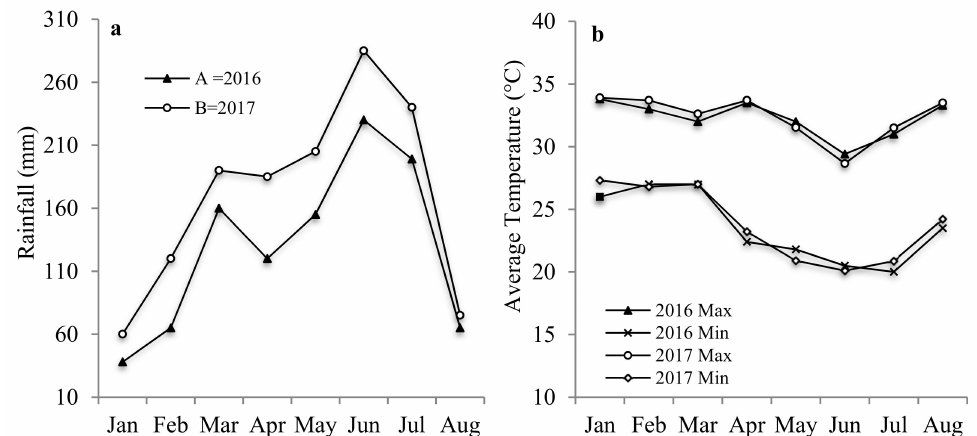
Figure 1. ( a ) Monthly variation of rainfall; and ( b ) monthly variation in